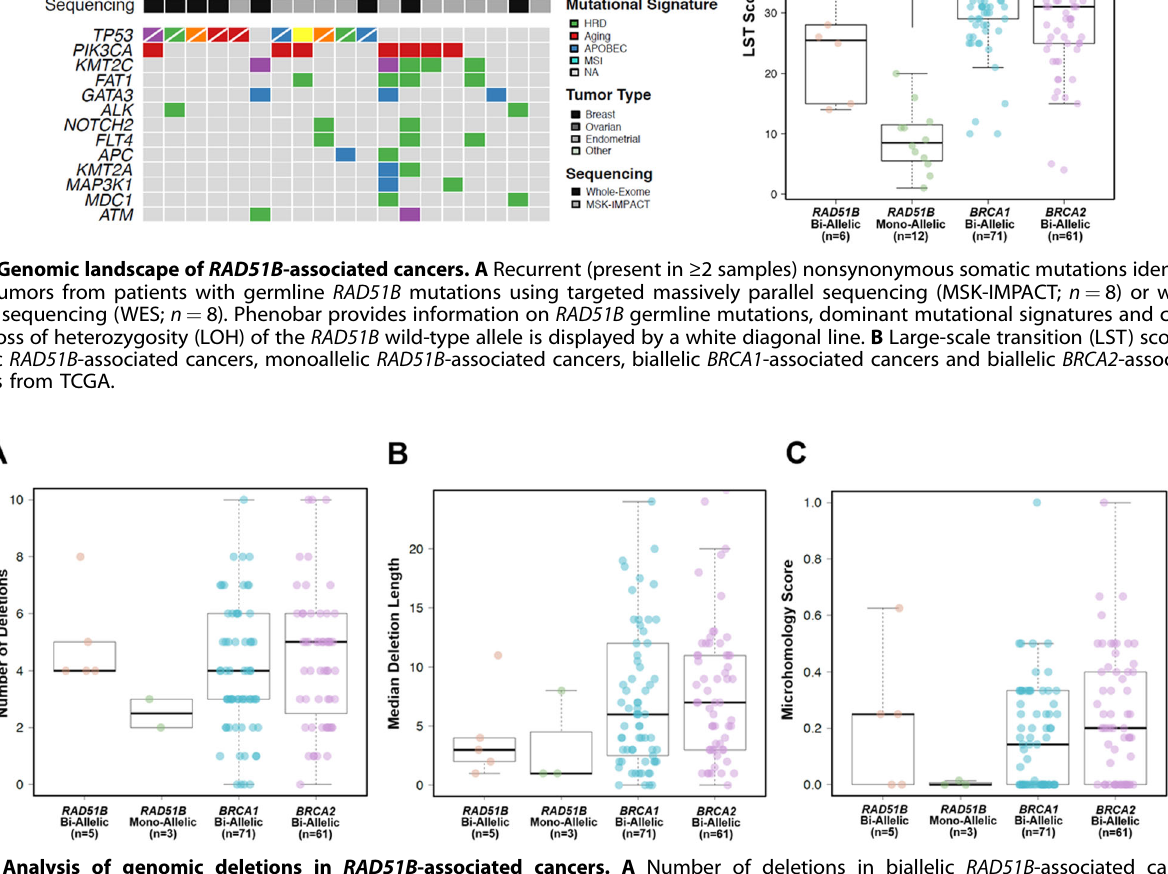
Fig. 2 Analysis of genomic deletions in RAD51B -associated cancers. A Number of deletions in biallelic RAD51B -associated cancers, monoallelic RAD51B -associated cancers, biallelic BRCA1 -associated cancers and biallelic BRCA2 -associated cancers. Note one mon-allelic RAD51B was removed from the plot due to a large number of indels (142) driven by microsatellite instability. B Median deletion length in biallelic RAD51B -associated cancers, monoallelic RAD51B -associated cancers, biallelic BRCA1 -associated cancers and biallelic BRCA2-associated cancers. C Deletion microhomology scores in biallelic RAD51B -associated cancers, monoallelic RAD51B -associated cancers, biallelic BRCA1 - associated cancers and biallelic BRCA2 -associated cancers. A deletion was classi fi ed as having microhomology when deletion length was ≥ 4 bases with homology ≥ 3 bases. Microhomology scores are calculated by dividing the total number of deletions with microhomology by the total number of